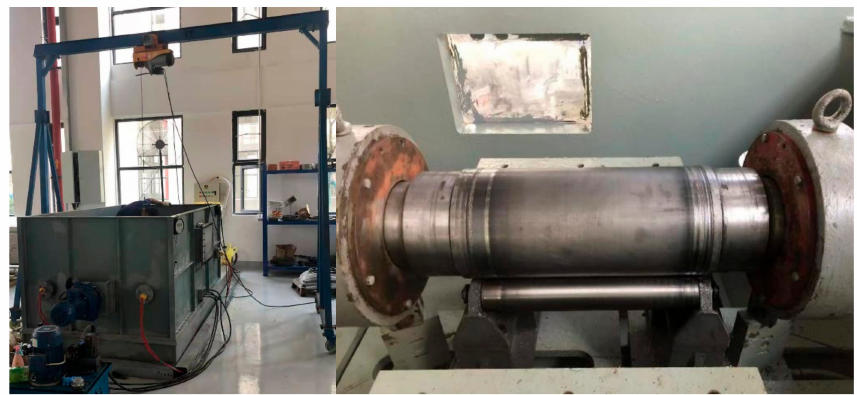
Figure 4. Calibration tooling of COF for test equipment.